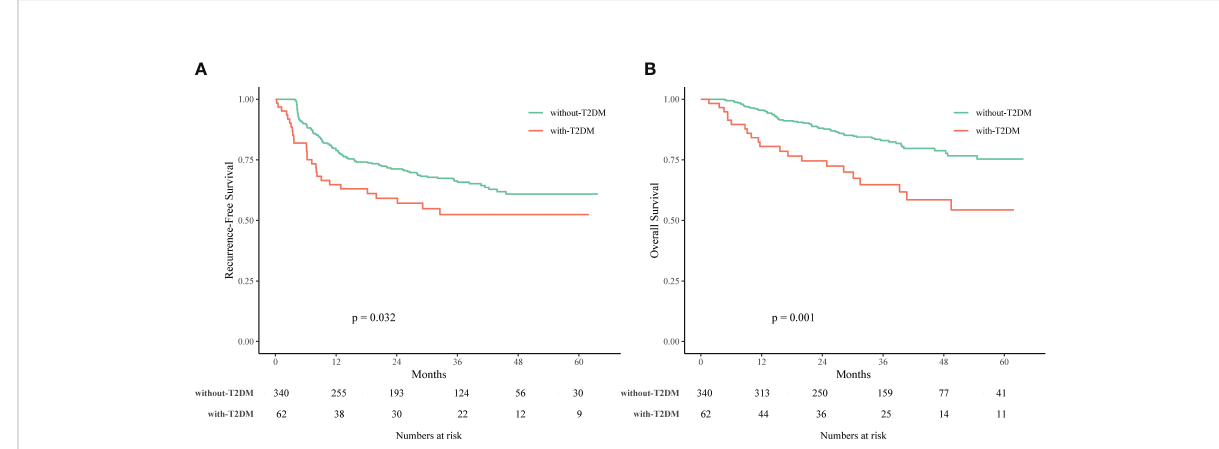
FIGURE 2 Recurrence-free survival (RFS) (A) and overall survival (OS) (B) of HCC patients associated with or without type 2 diabetes mellitus (T2DM) treated with laparoscopic liver resection